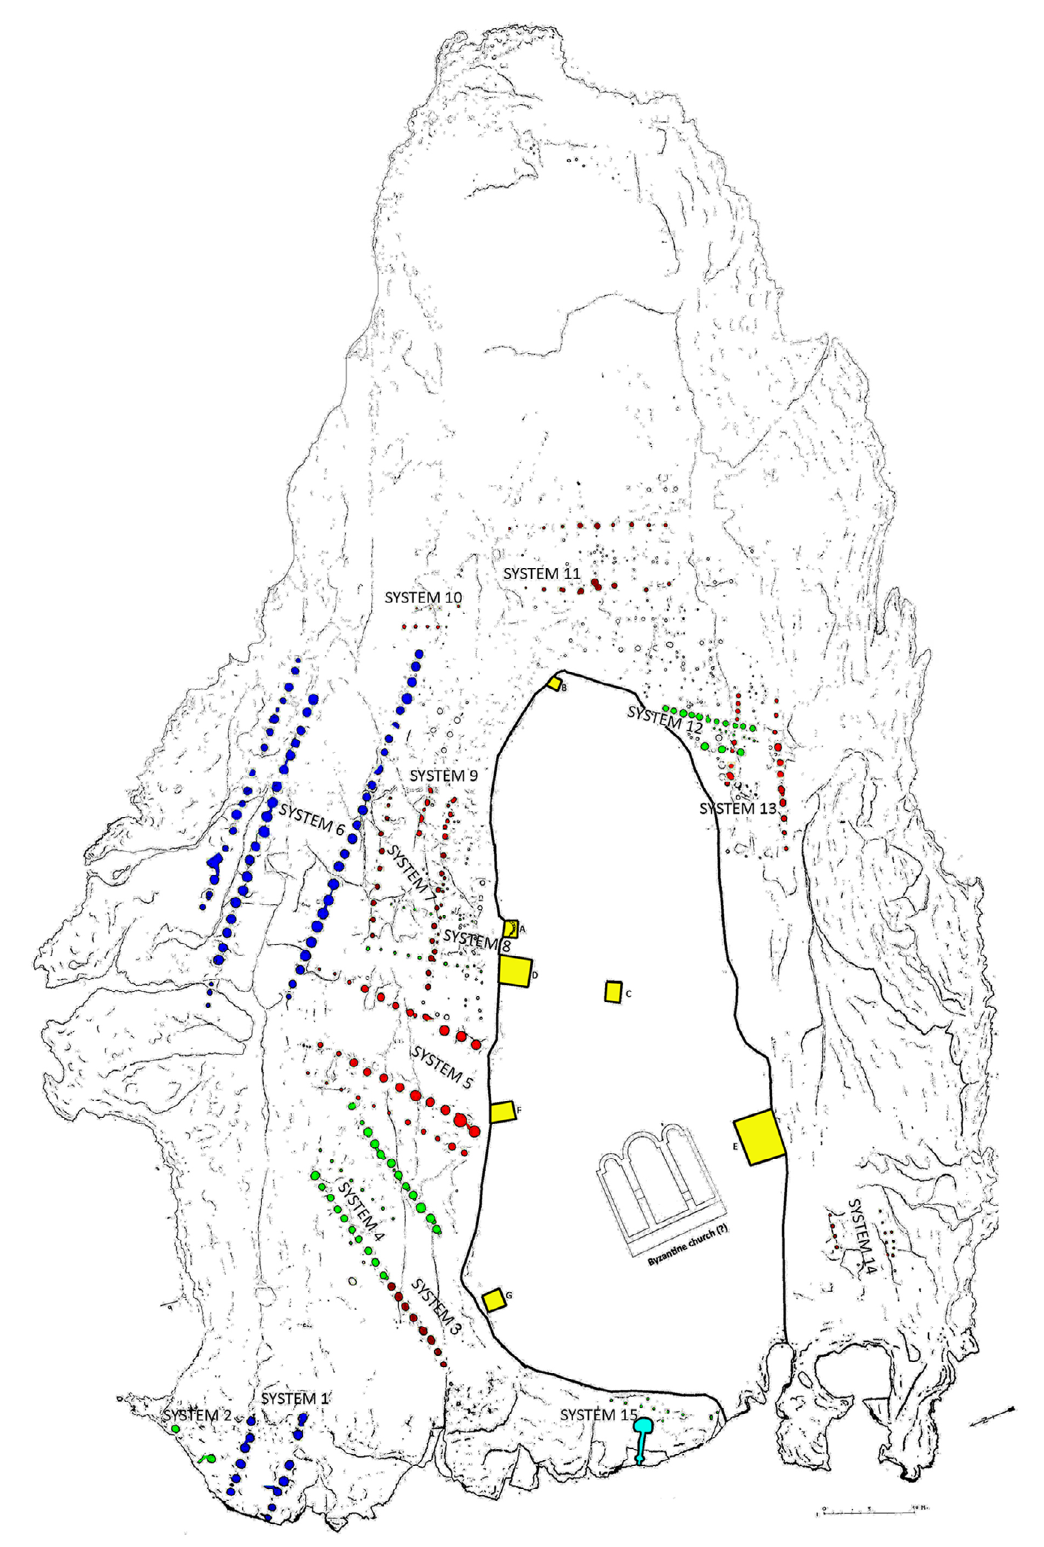
Figure 1. Plan of the islet of Ognina (after Bernabò Brea,